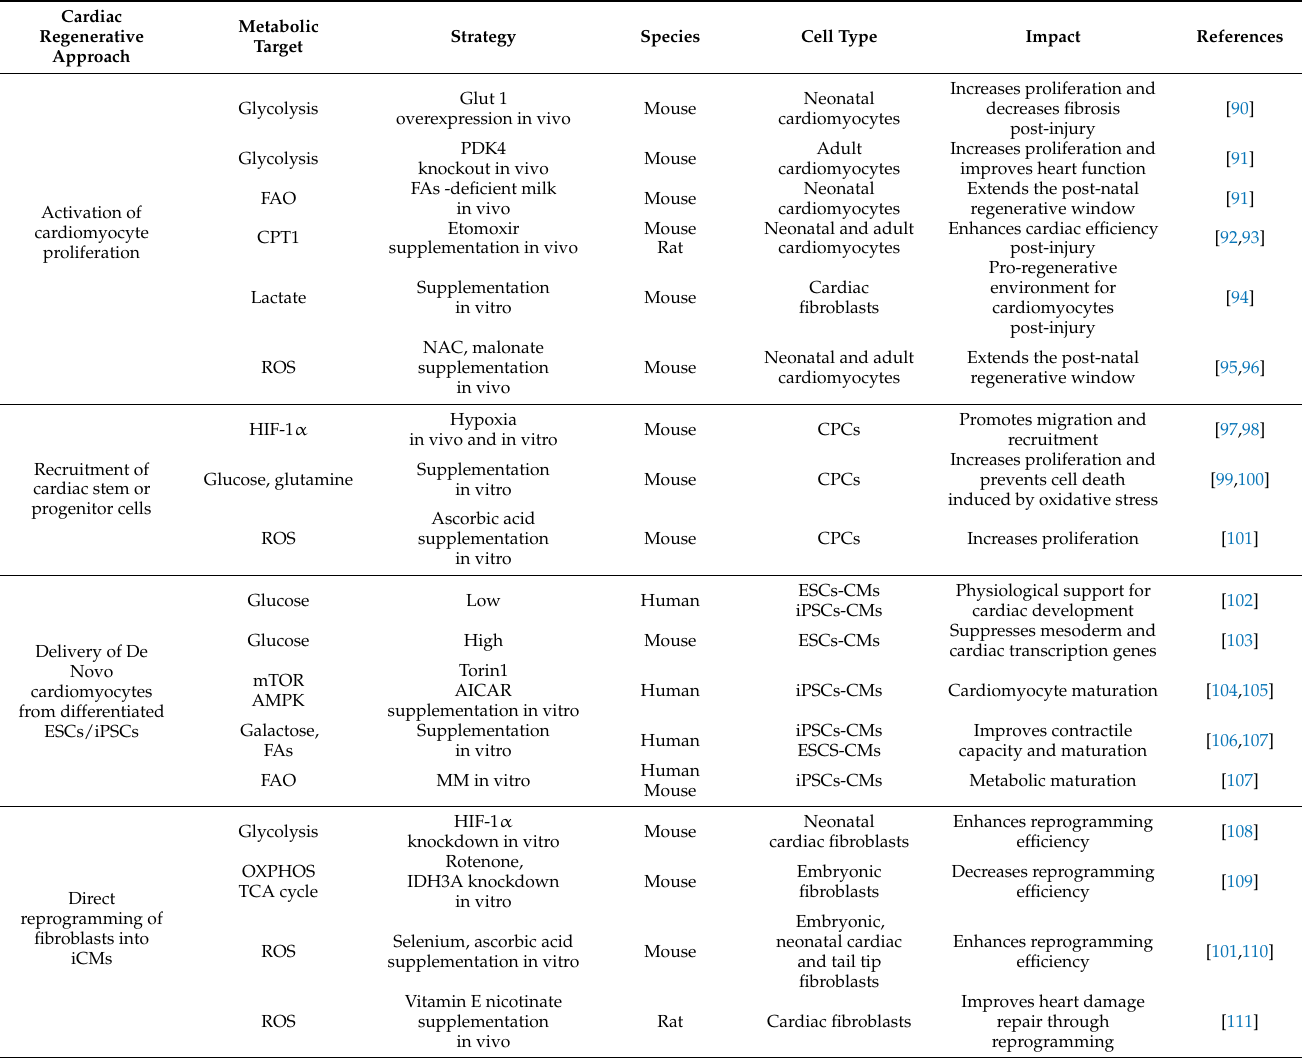
Table 1. Metabolic manipulations that potentiate cardiac regenerative